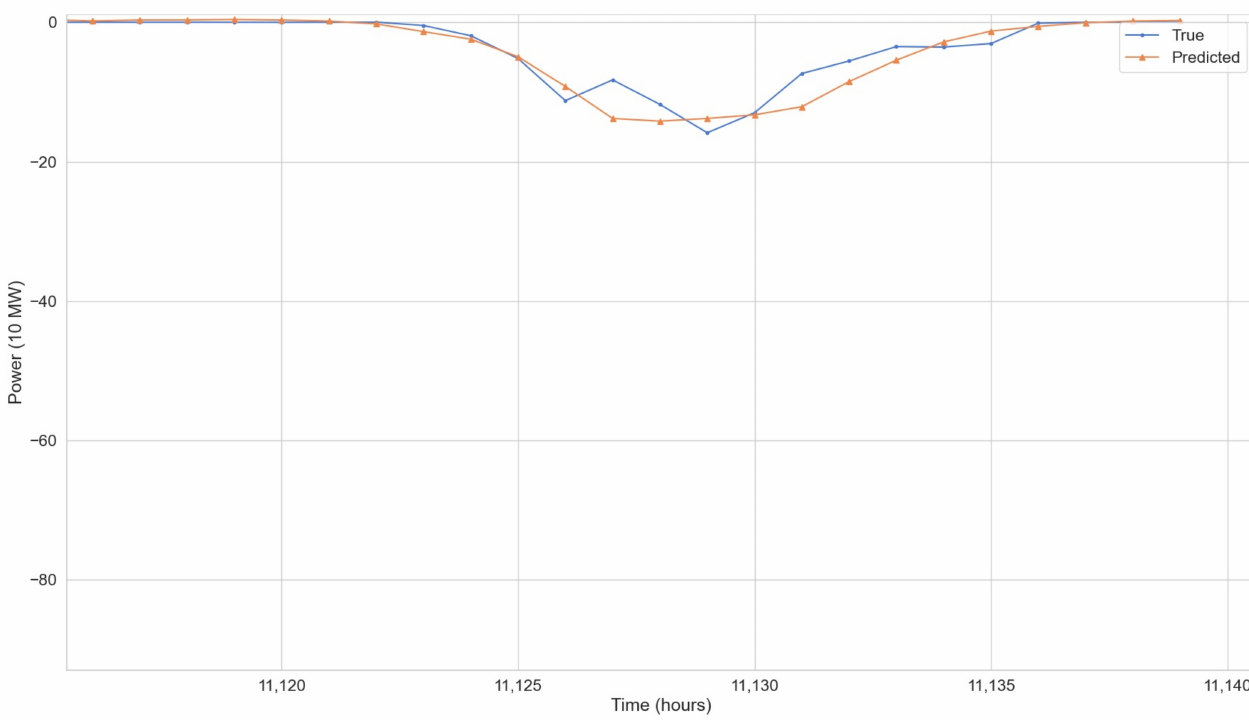
Figure 12. True vs. Predicted PV capacity output for 1